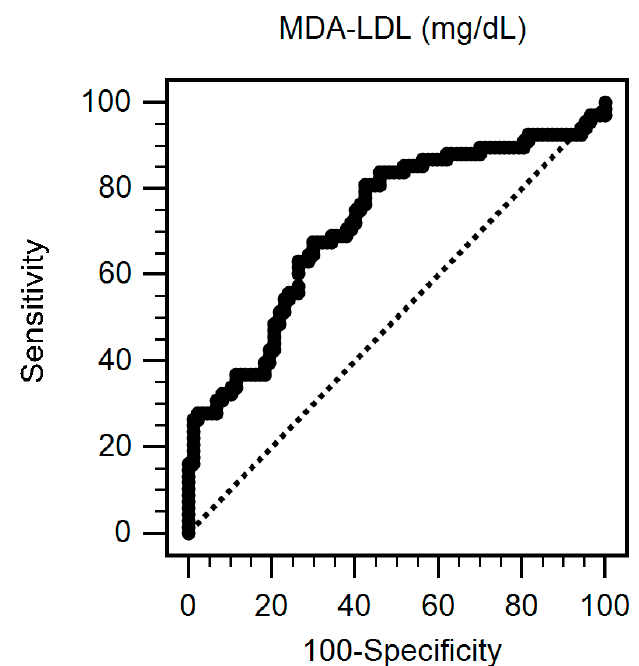
Figure 1. Receiver operating characteristic (ROC) curve analysis to predict aortic stiffness in 155 hemodialysis patients. The area under the ROC curve (AUC) indicates the diagnostic power of malondialdehyde-modified low-density lipoprotein (MDA-LDL) level at predicting aortic stiffness in hemodialysis patients. The AUC for MDA-LDL level was 0.721 (95% confidence interval: 0.643–0.790, p < 0.001).